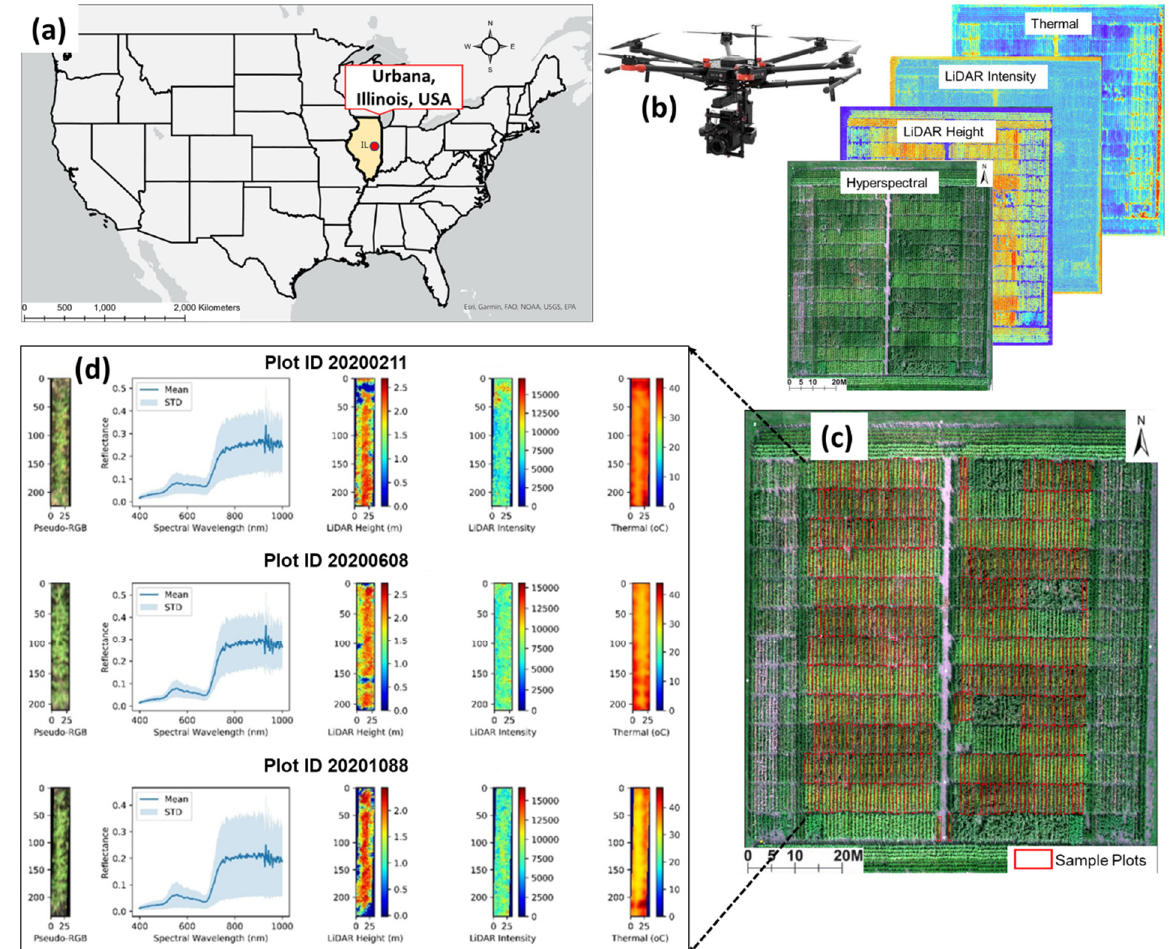
Figure 1. Experiment site location (red dot) in Urbana, Illinois, USA ( a ), UAV aerial hyperspectral, LiDAR, and thermal data collected from the field ( b ), the ortho-mosaic of maize field and samples plots (red polygons) ( c ), UAV hyperspectral, LiDAR height, LiDAR intensity, and thermal data of random plots enlarged and visually projected ( d ).